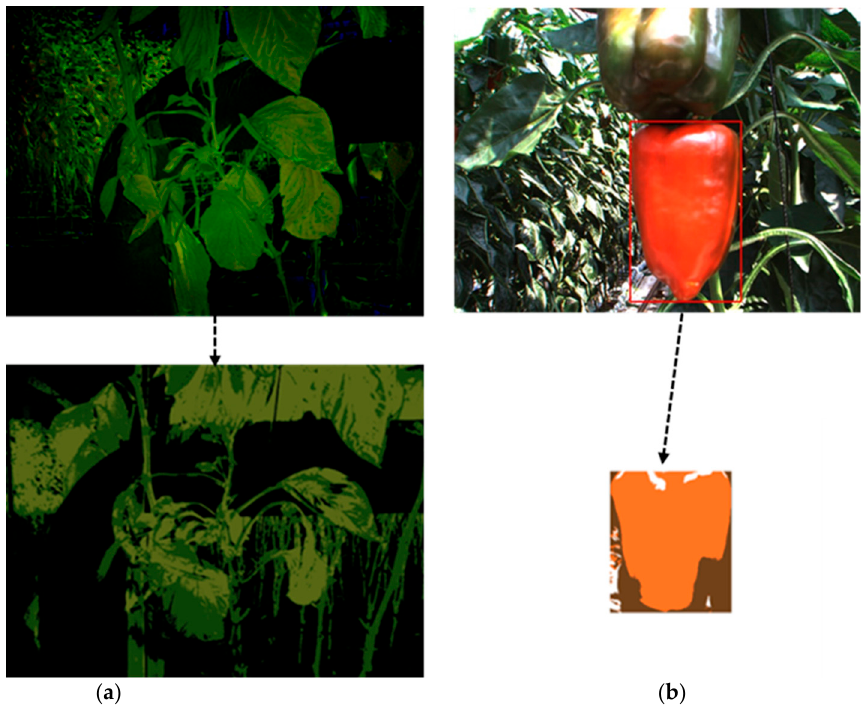
Figure 13. Image segmentation of steam, leaves, suckers ( a ), and fruits ( b ) by k-means clustering. Table 4. Numbers of parts retained after image segmentation.